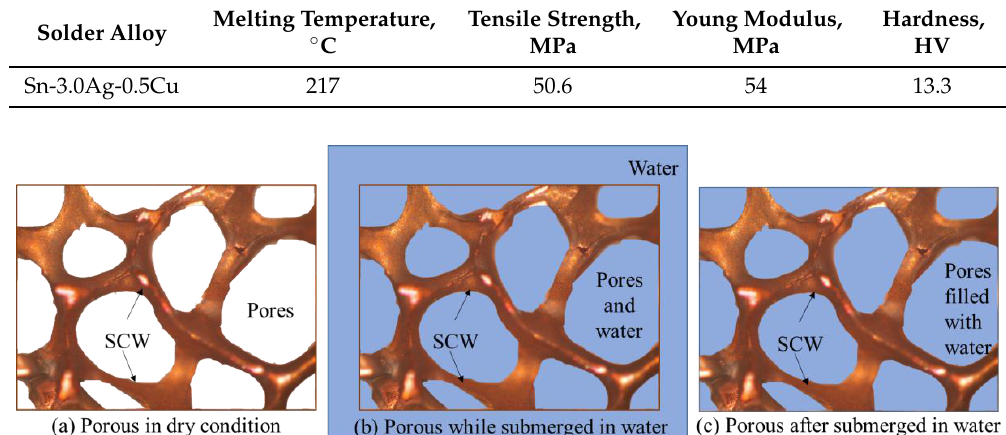
Figure 1. Archimedes’ technique to calculate porosity of porous Cu interlayer. ( a ) Porous in dry condition; ( b ) porous while submerged in water; ( c ) porous after submerged in water.